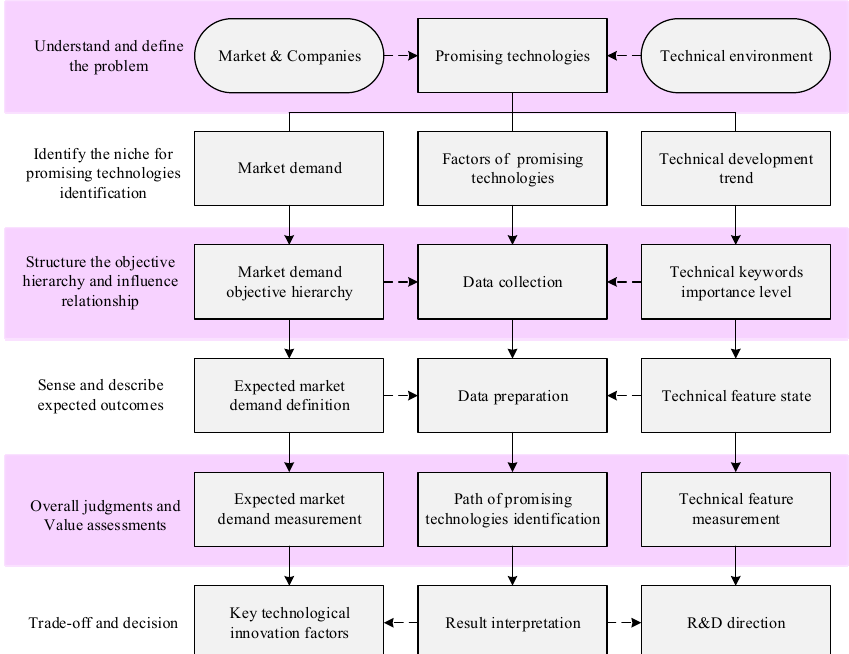
Figure 1. UNISON framework for identifying promising technologies.